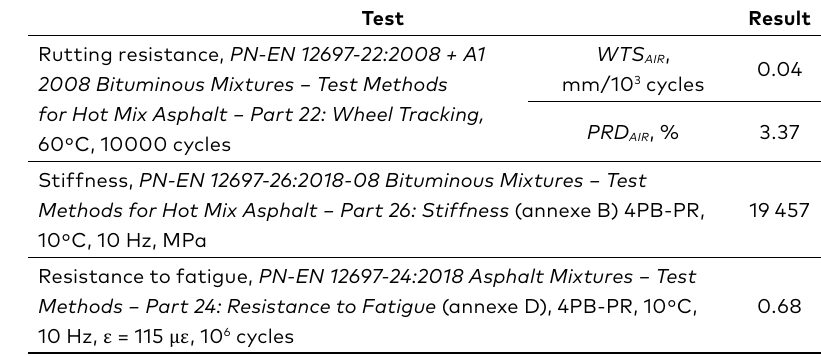
Table 3. Results of the experimental determination of the bituminous concrete